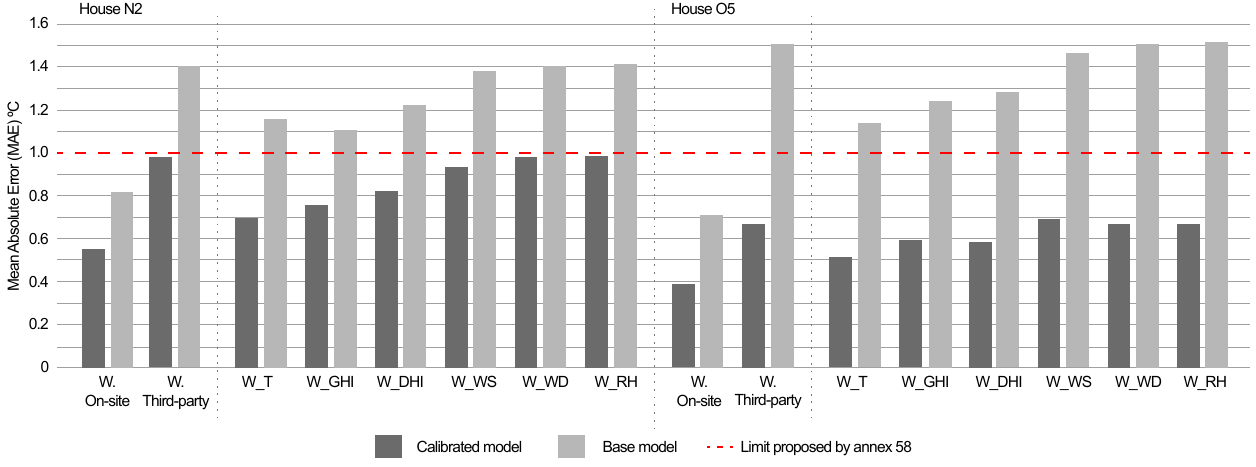
Figure 7. Results of the MAE index of the base and calibrated models with the different weather files created. Training period, Houses N2 and O5.